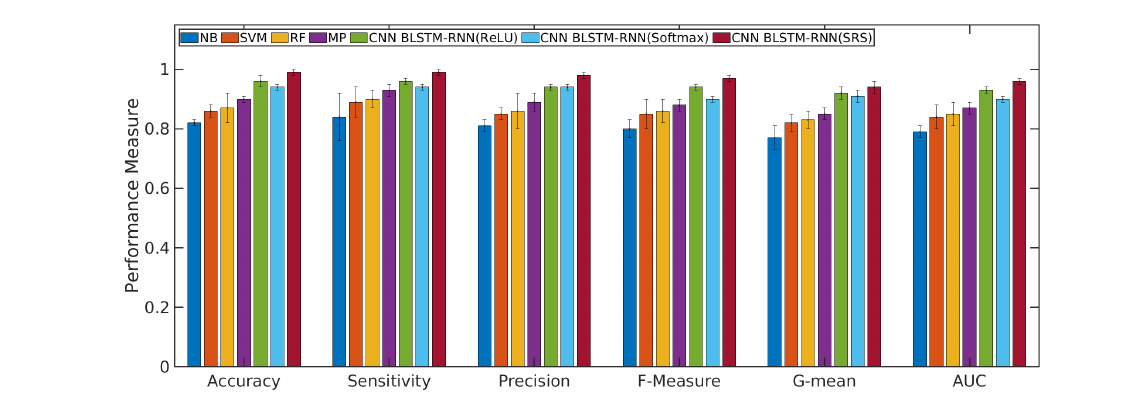
Figure 5. Results of machine learning algorithms for classifying the negative sentences.